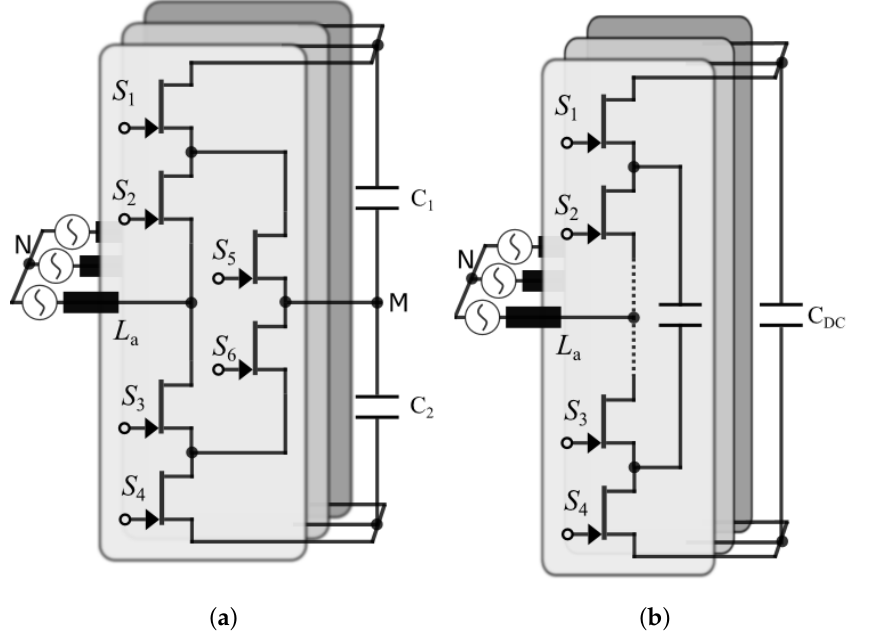
Figure 11. ( a ) Three-phase three-level active neutral point clamped ANPC converter (derived from [106,107]) and ( b ) three-phase flying-capacitor multi-level (FCML) converter (derived from